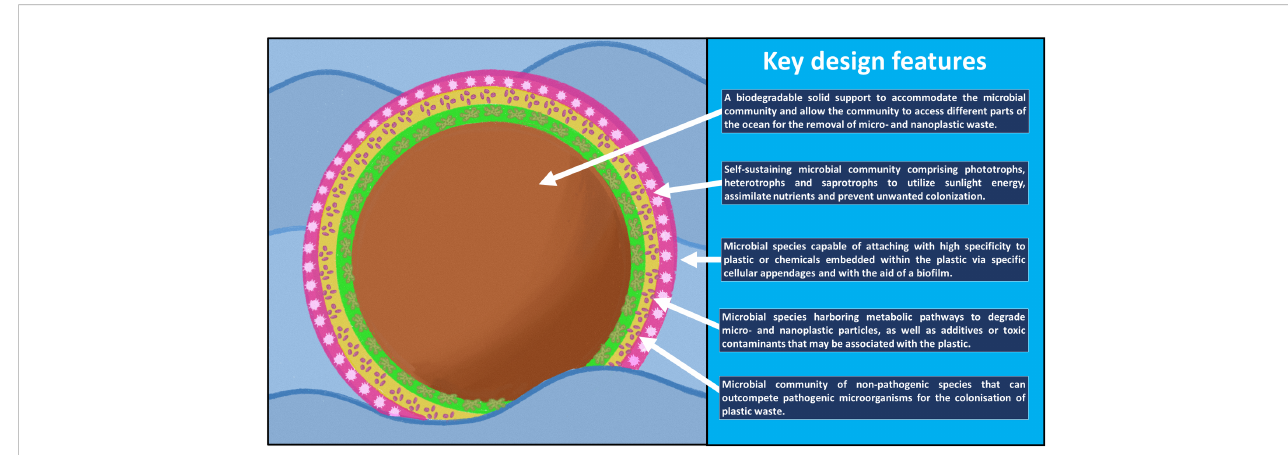
FIGURE 1 Key design features of the proposed